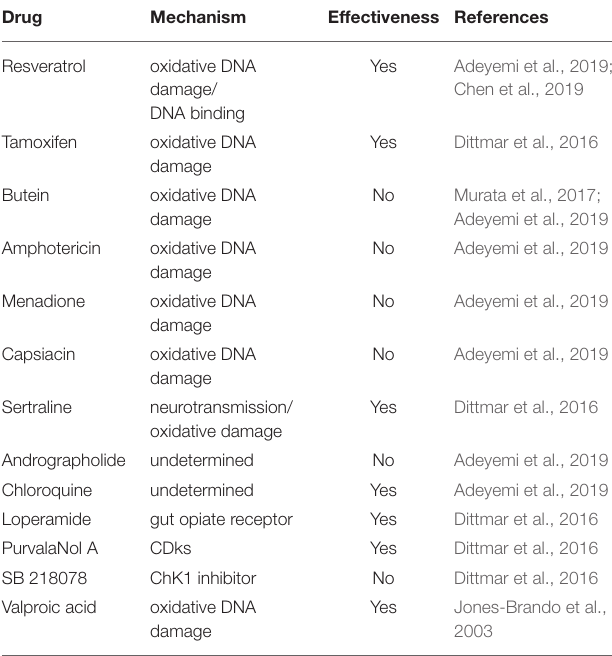
TABLE 1 | DNA damaging agents tested in T. gondii models. TABLE 2 | Non direct DNA damaging agents used in T. gondii